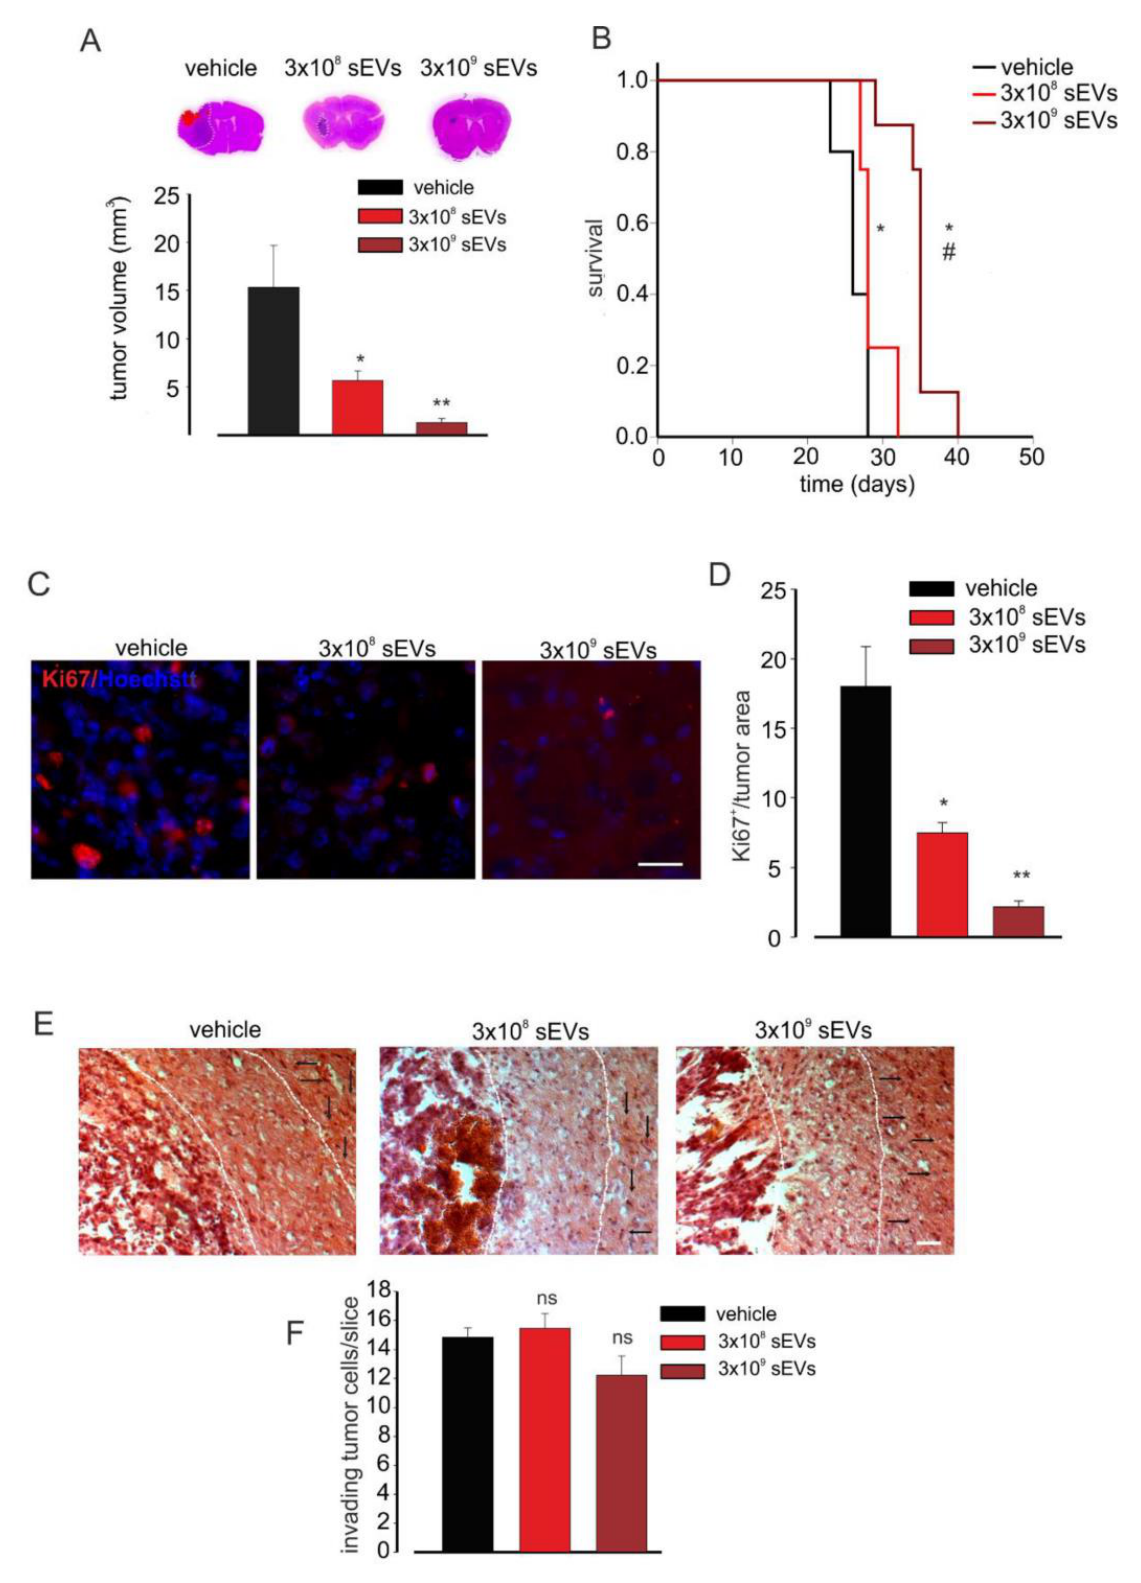
Figure 3. Microglia-derived sEV effects on tumor size and survival in glioma-bearing mice. ( A ) Tumor size in the brain of GL261-bearing mice treated with a vehicle or 3 × 10 8 or 3 × 10 9 BV2-derived sEVs. Tumor size (in mm 3 ) was reported as mean ± SE; N = 7 mice/experimental group in vehicle and 3 × 10 8 groups and N = 6 mice/experimental group in 3 × 10 9 group; * p < 0.05, ** p ≤ 0.001 vs. vehicle; by using Student’s t -test. On the top, representative coronal brain sections of GL261-bearing mice treated as above, stained with hematoxylin and eosin; the tumor area is indicated by the dashed line. ( B ) Kaplan–Meier survival curves of GL261-bearing mice treated with 3 × 10 8 or 3 × 10 9 BV2-derived sEVs obtained from 1 × 10 6 or 1 × 10 7 cells. N = 10 mice/experimental group in vehicle group and N = 8 mice/experimental group in 3 × 10 9 and 3 × 10 8 groups; Gehan-Breslow statistic for the survival curves ( p < 0.001); multiple comparisons: * p ≤ 0.05 vs. vehicle, # p ≤ 0.05 3 × 10 8 sEVs vs. 3 × 10 9 sEVs; by using the Holm-Sidak test. ( C ) Representative immunofluorescence analysis for Ki67 (in red; Hoechst in blue) of coronal brain sections of GL261-bearing treated with a vehicle